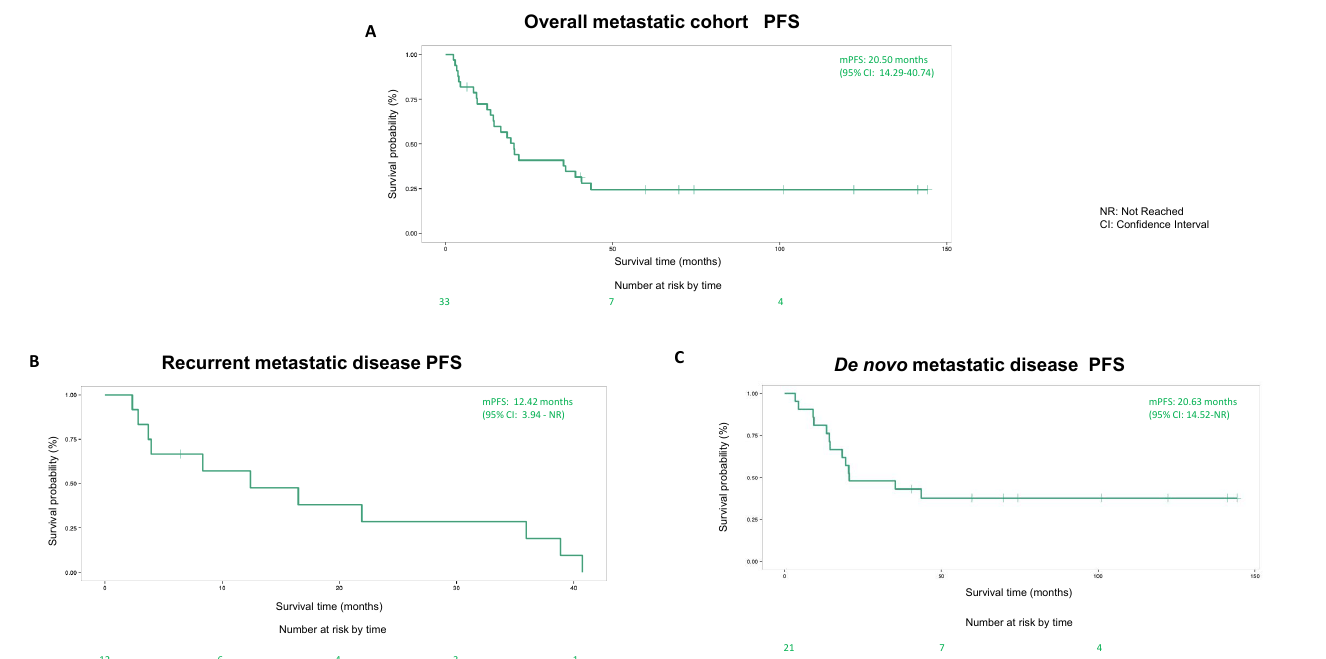
Figure 1—Clinical outcomes (PFS) for metastatic GIST patients who underwent surgery